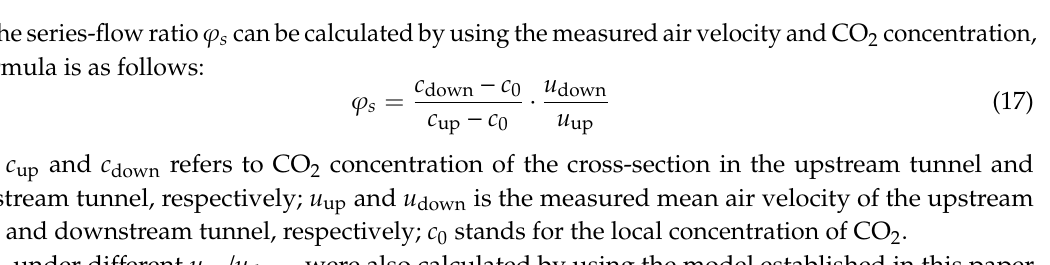
Figure 12. Comparison of predicted φ s with measured results.